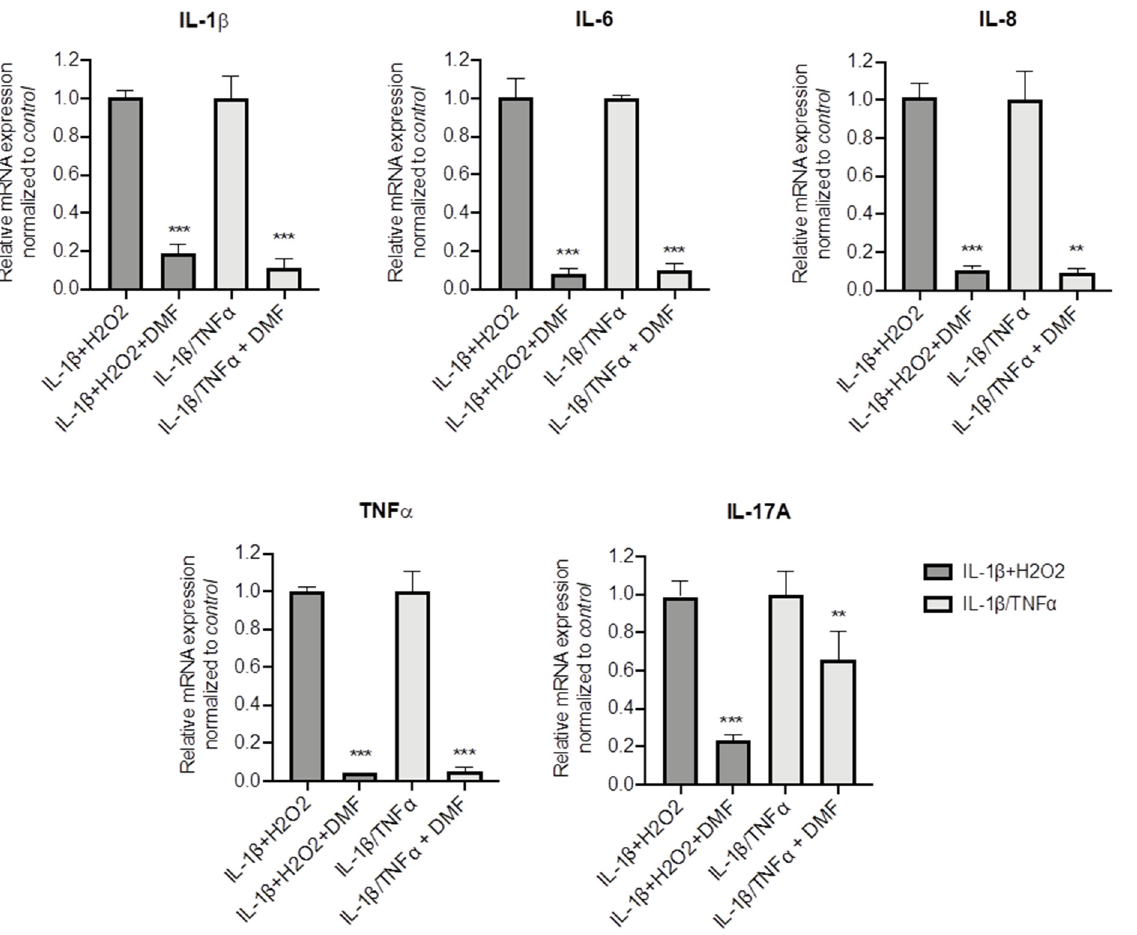
Figure 4. Co-treatment with DMF reduced the pro-inflammatory cytokines expression stimulated by IL-1 β + H 2 O 2 and IL- 1 β + TNF- α in CFBE cells. Cells were incubated with 0.1% DMSO or 50 µM DMF +/ − 30 ng/mL IL-1 β + 100 µM H 2 O 2 or 30 ng/mL IL-1 β + 30 ng/mL TNF- α for 4 h. The qRT-PCR was performed in order to quantify IL-1 β , IL-6, IL-8, TNF- α and IL- 17A mRNA normalized to untreated control. Results are shown as fold induction where CTRL is equal to 1. Data represent the mean ± SD ( n = 4). ** p < 0.01; *** p < 0.001.